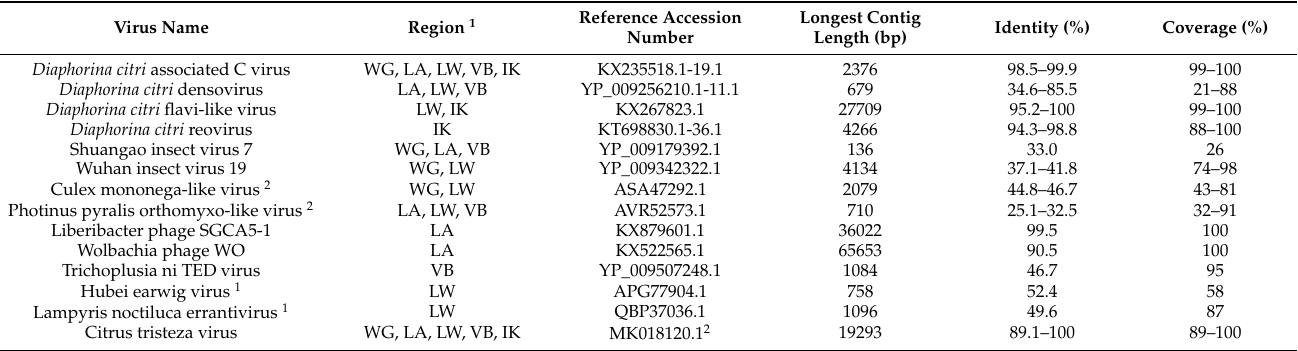
Table 3. Insect specific virus and Citrus tristeza virus sequences from D. citri gut RNA-seq in five Florida regions identified by alignment against NCBI